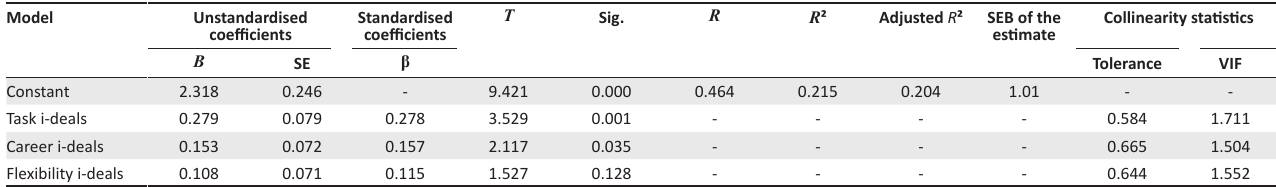
TABLE 3: Regression analysis of idiosyncratic deals predicting work engagement.